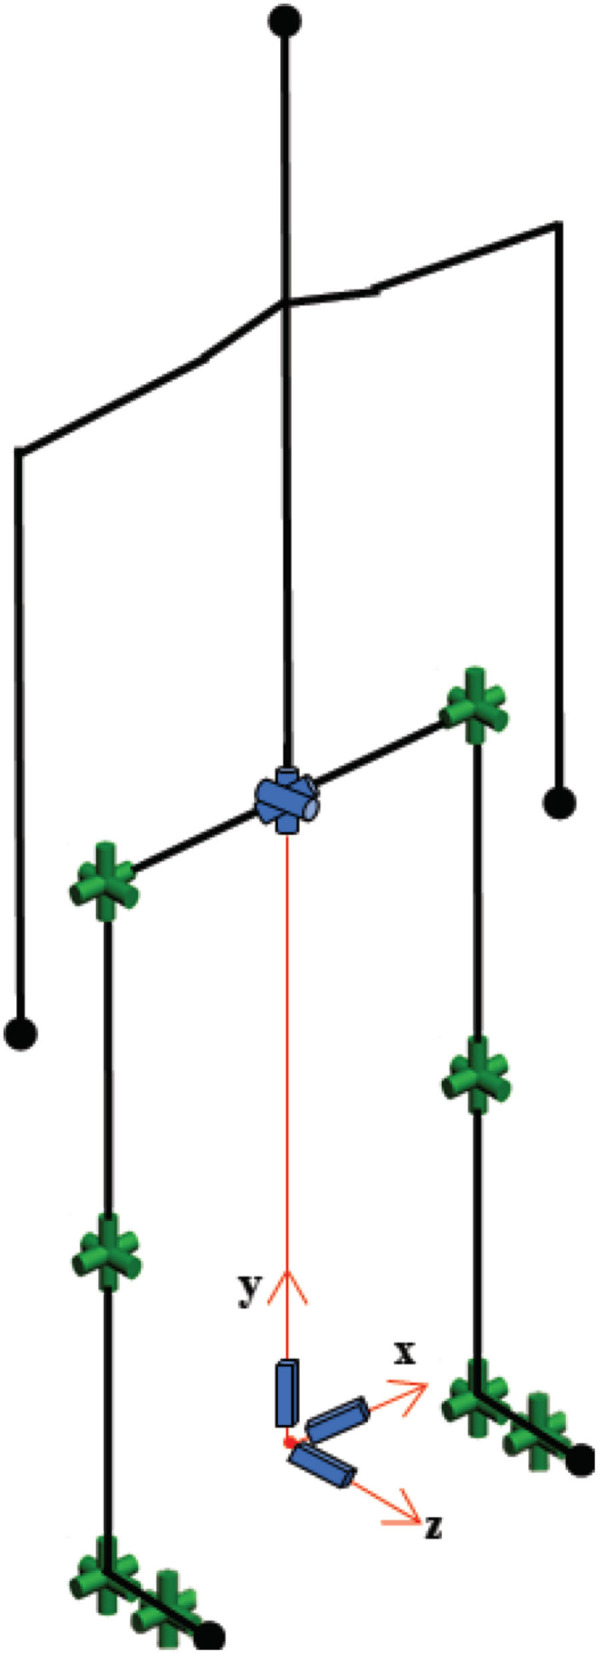
The biomechanical model used for the gait analysis.